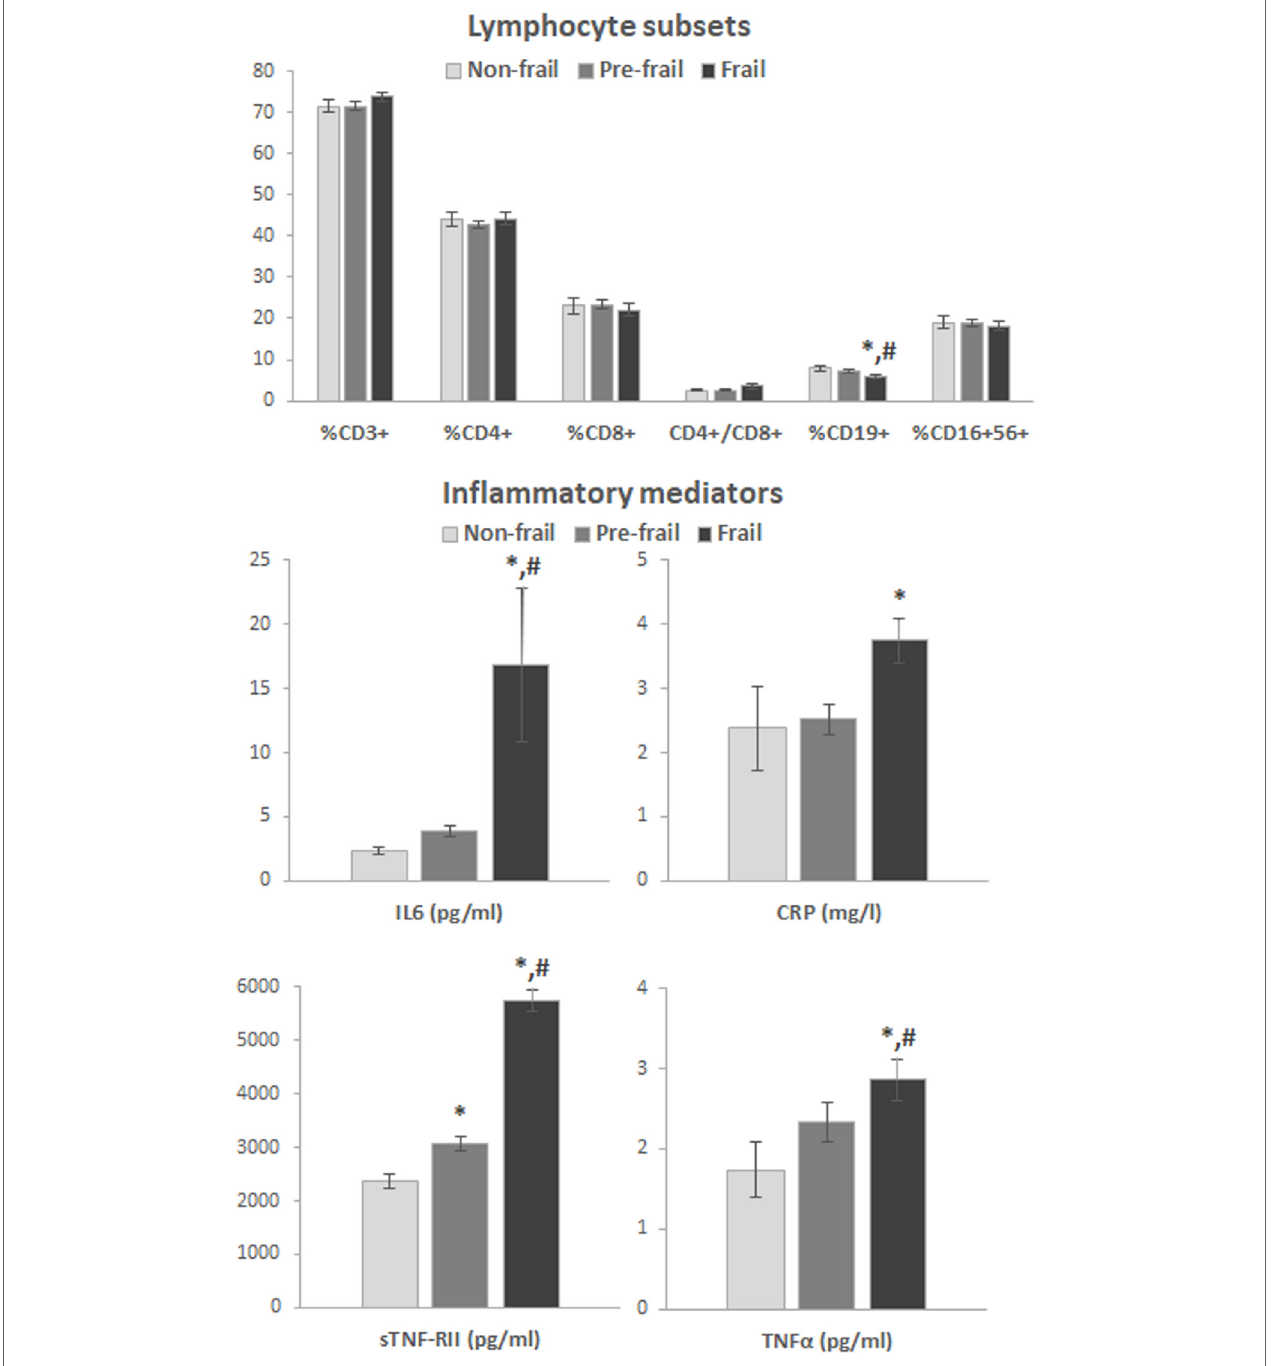
FigUre 1 | Results of immunological biomarkers in the study group, classified according to frailty status (univariant analysis). Bars represent mean standard error. *Statistically different from non-frail, # statistically different from pre-frail (Tukey’s test or Bonferroni’s correction). Abbreviations: CRP, C-reactive protein, IL6: interleukin 6, TNF α : tumor necrosis factor alpha, sTNF-RII, soluble tumor necrosis factor alpha receptor